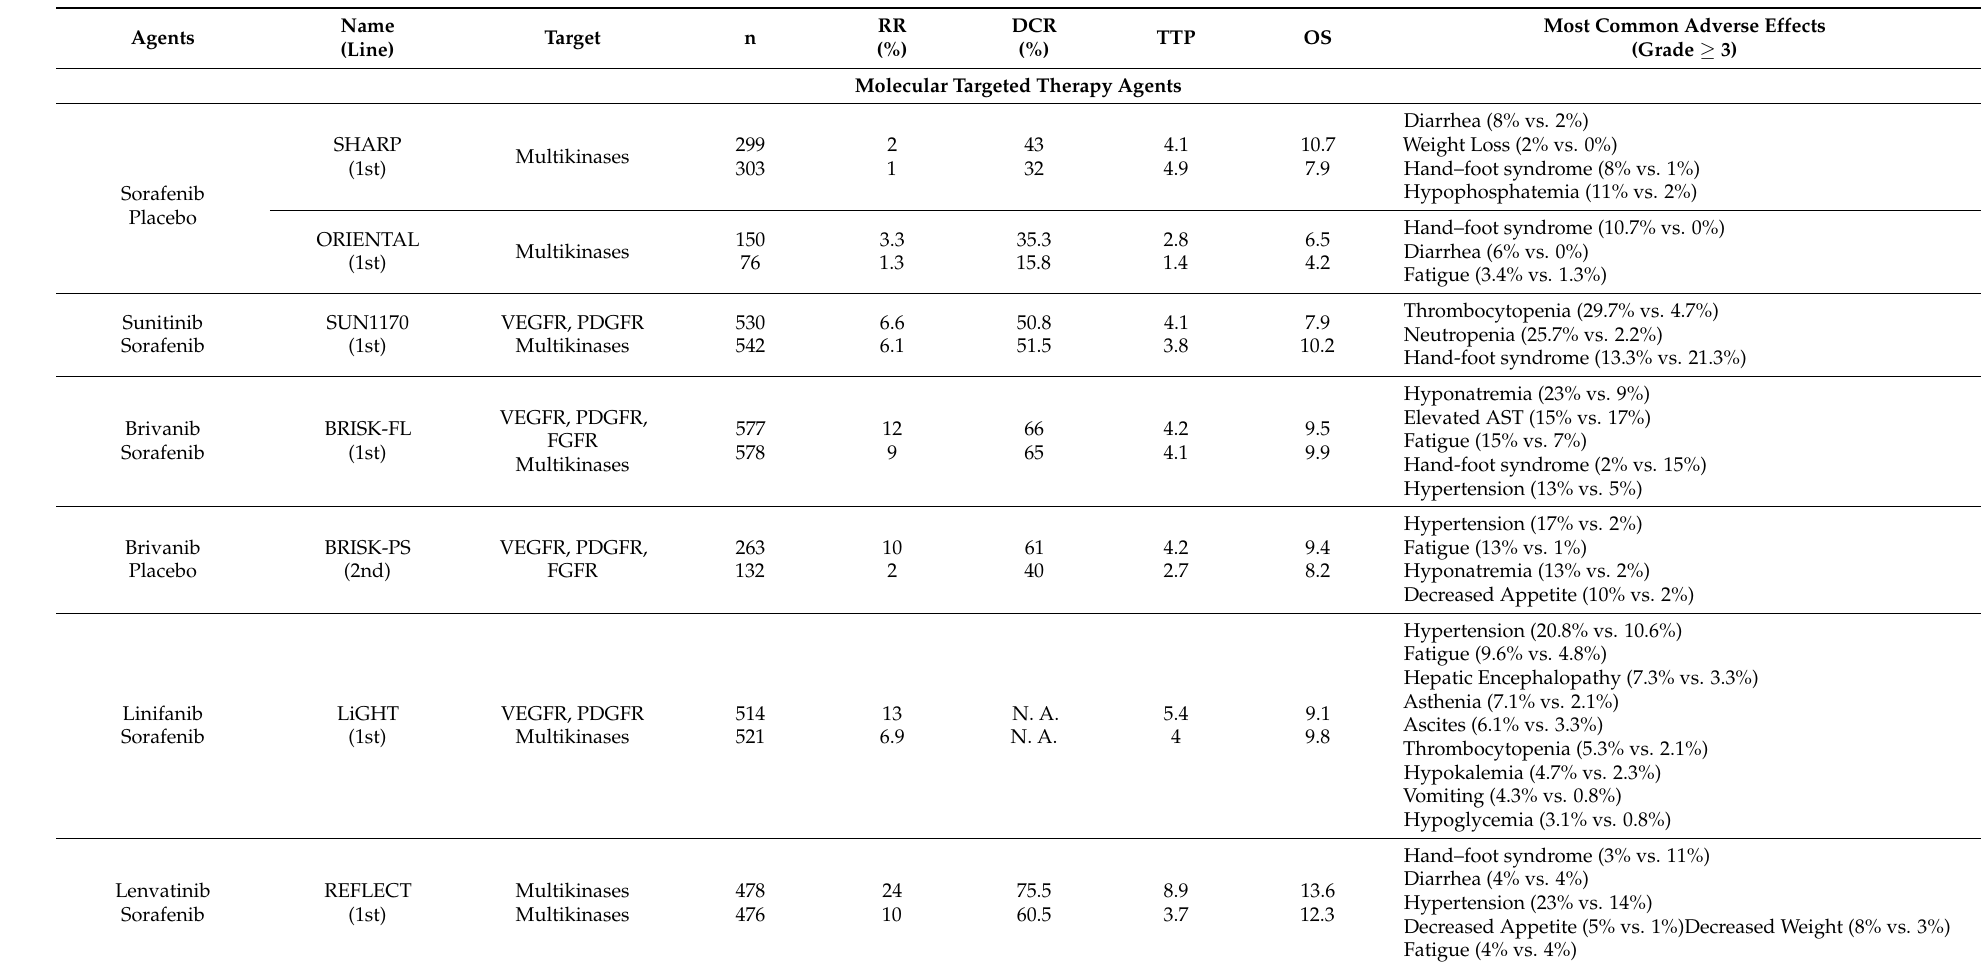
Table 4. Clinical trials used for targeted therapy and immunotherapy of patients with unresectable